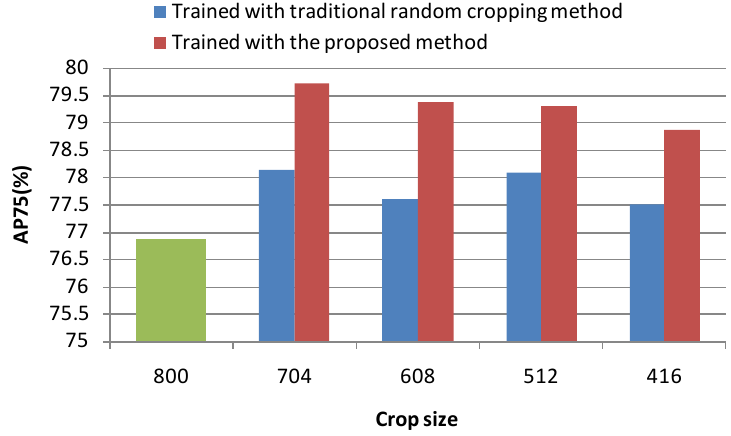
Figure 11. AP75 of different models under different random crop sizes. Table 4. Test results of different